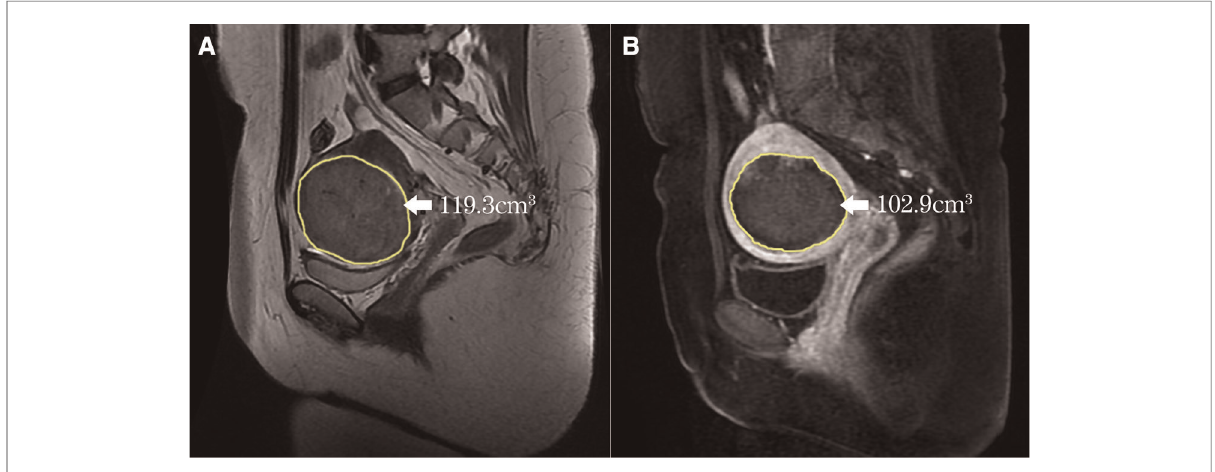
FIGURE 2 Measurement of the volume of the fi broid and the NPV (yellow line). ( A ) The fi broid was outlined on every slice of MRI, the automatically generated volume was 119.3 cm 3 ; ( B ) The NPV was also outlined on every slice of CE-T1WI, the automatically generated NPV was 102.9 cm 3